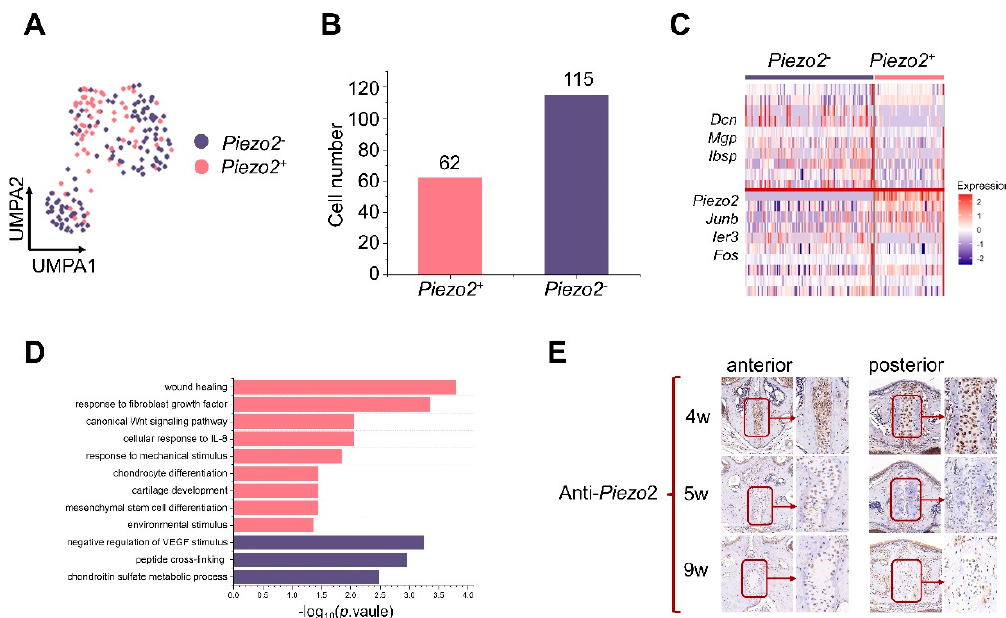
Figure 5. Piezo2 + chondrogenic mesenchymal cells are linked to the detection of mechanical stimuli. ( A ) Feature plots showing the expression of Piezo2 + and Piezo2 − chondrogenic mesenchymal cells color coded by whether the cells expressed Piezo2 or not. ( B ) Bar graphs showing the cell number of Piezo2 + (62 cells) and Piezo2 − (115 cells) chondrogenic mesenchymal cells. ( C ) Heatmap showing the average expression of the top differentially expressed genes for Piezo2 + and Piezo2 − chondrogenic mesenchymal cells. ( D ) Bar graphs showing the enriched gene ontology terms of Piezo2 + and Piezo2 − chondrogenic mesenchymal cells. ( E ) The immunohistochemical staining results of Piezo 2 are shown in order at 4, 5, and 9 weeks of age. Scale: 12× and 24× (magnified on the right).